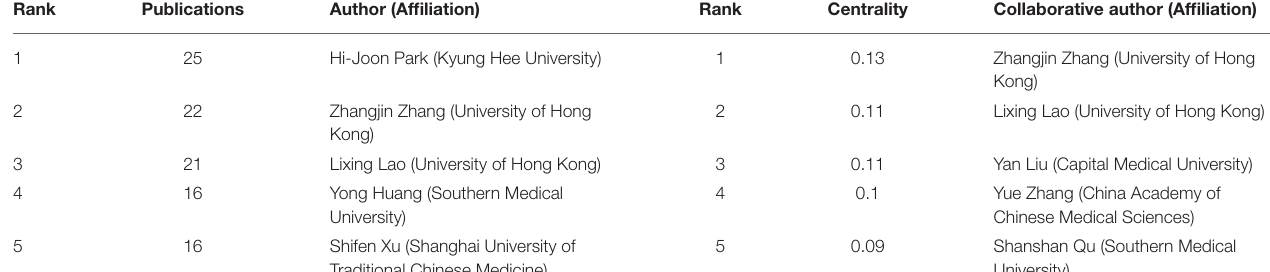
TABLE 5 | Top five prolific authors and centrality of collaborative authors related to acupuncture therapy on depression. Rank Publications